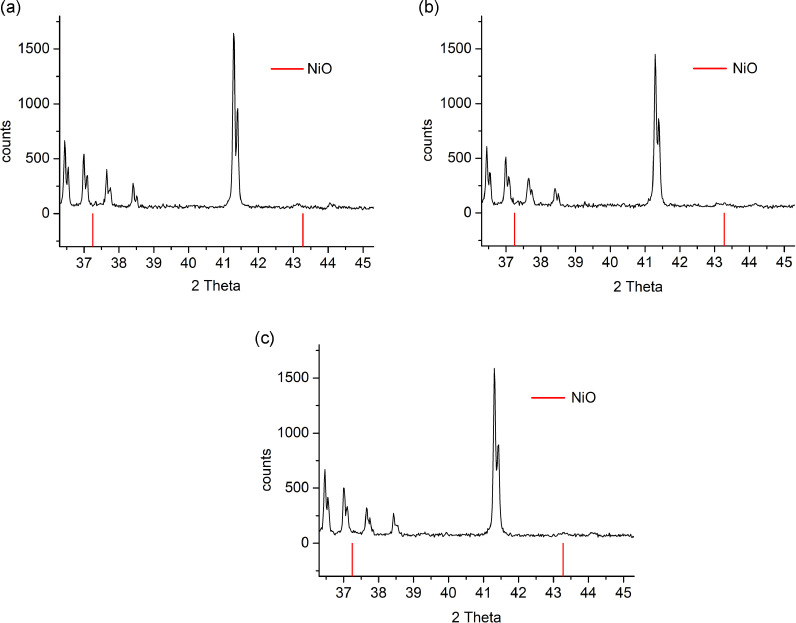
XRD-patterns of (a) Ba0.5Sr1.5Zn1.2Ni0.8Fe12O22, (b) Ba0.5Sr1.5ZnNiFe12O22 and (c) Ba0.5Sr1.5Zn0.5Ni1.5Fe12O22 in the 2-theta range 37.3° – 45.3°. The expected peak positions of NiO (PDF number 00–047–1049) are marked in red.